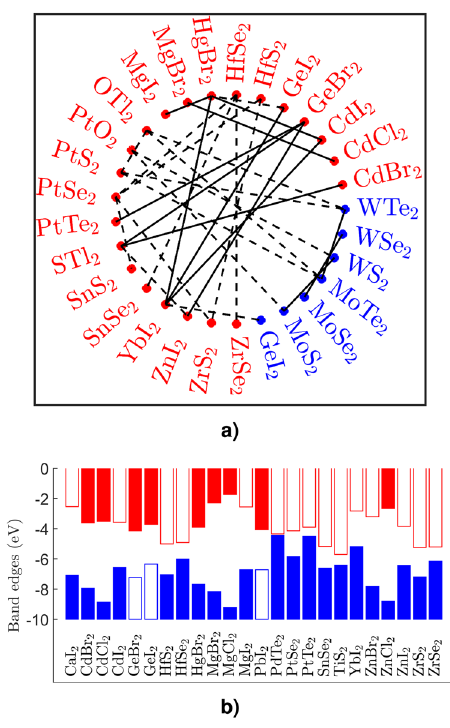
Fig. 6 Summary of the electronic properties of type-II hetero- structures with minimal unit cell and band edges at Γ . a “ Network ” representation of the vdWHs having an in-plane unit cell corre- sponding to the ML primitive cell. Red (blue) compounds are 1T (2H) type. The dashed lines indicate that the MLs pair forms a vdWH with indirect band gap, while the solid ones are for direct vdWHs. b Band alignment for MLs with band edges at Γ (solid blocks). Blue blocks represent the valence bands and red blocks the conduction ones. A hollow block indicates that the corresponding band edge is not at Γ